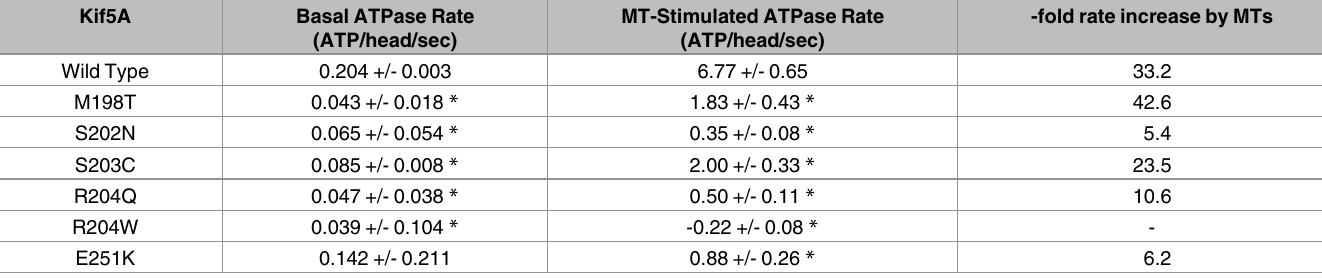
Data shown are the average rate for at least three sample runs performed from a minimum of two different protein preparations. * indicates rates that are significantly lower than the corresponding wild type rate (p <